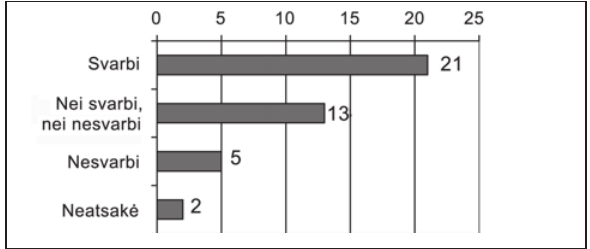
16 pav. Centro ir periferijos disproporcijø vertinimas pagal ekspertø apklausos rezultatus 2005 m. Fig16. Estimation of disproportions between the centre and periphery according to the experts’ poll results,